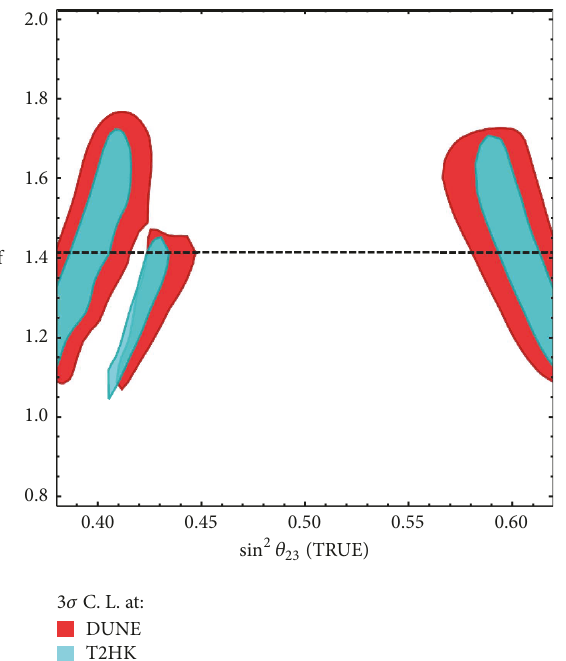
Figure 5: Regions that future neutrino long-baseline oscillation experiments cannot exclude the models that follow (15) at more than 3 𝜎 CL as a function of the true value of the atmospheric mixing angle for DUNE (red) and T2HK